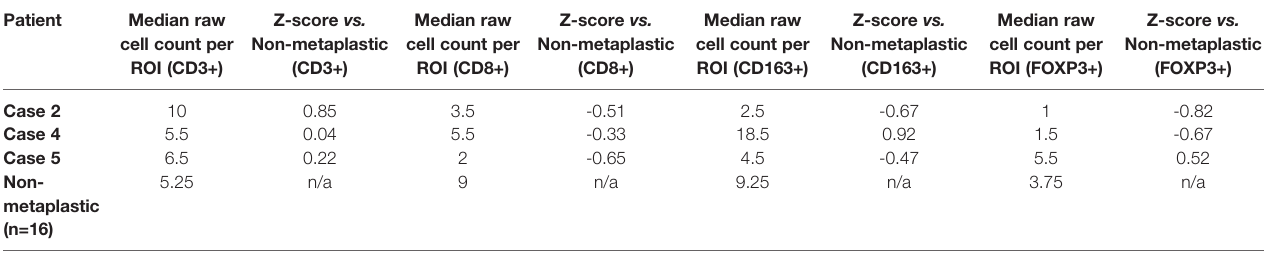
TABLE 4 | Comparison of mIF cell counts.